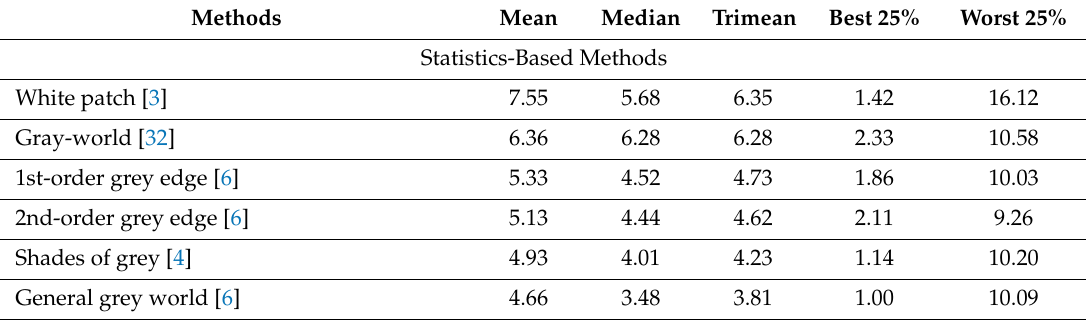
Table 1. Comparative statistical metrics between the proposed network and conventional methods with Shi’s re-processed dataset and the NUS-8 Camera Dataset (the lower, the better).